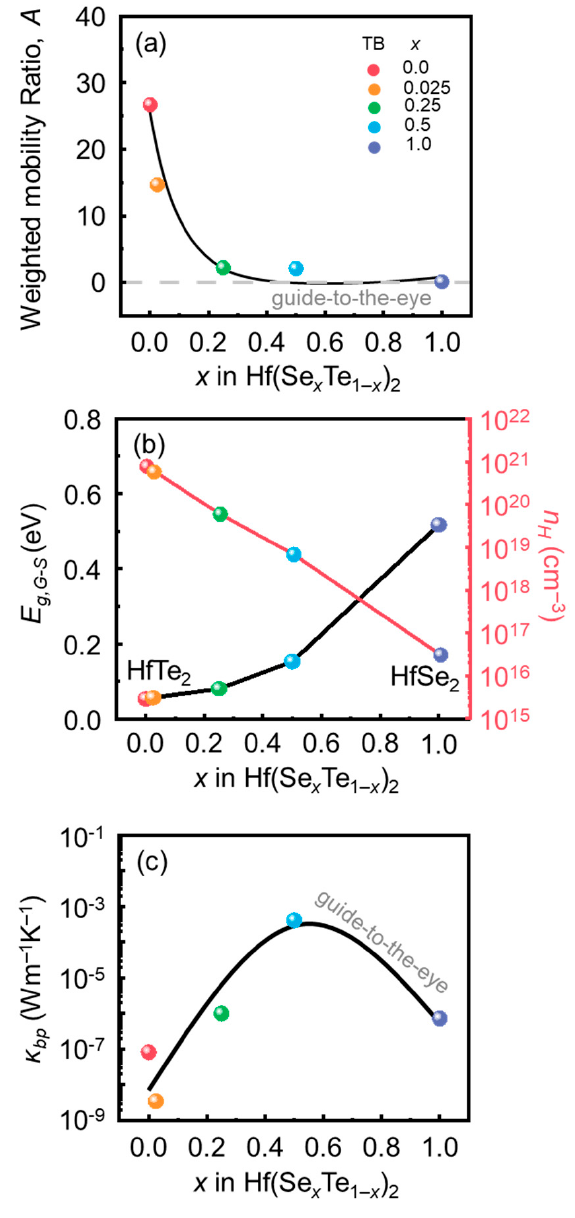
Figure 4. ( a ) Theoretical (symbols)-weighted mobility ratio a in terms of x for Hf(Te 1 − x Se x ) 2 ( x = 0.0, 0.025, 0.25, 0.5, and 1.0) at 300 K, ( b ) experimental (symbols) band gap estimated via Goldsmid–Sharp equation ( E g,G-S ), and experimental (symbols) n H in terms of x at 300 K [22], ( c ) theoretical (symbols) bipolar thermal conductivity ( κ b ) estimated for different x via the TB model at 300